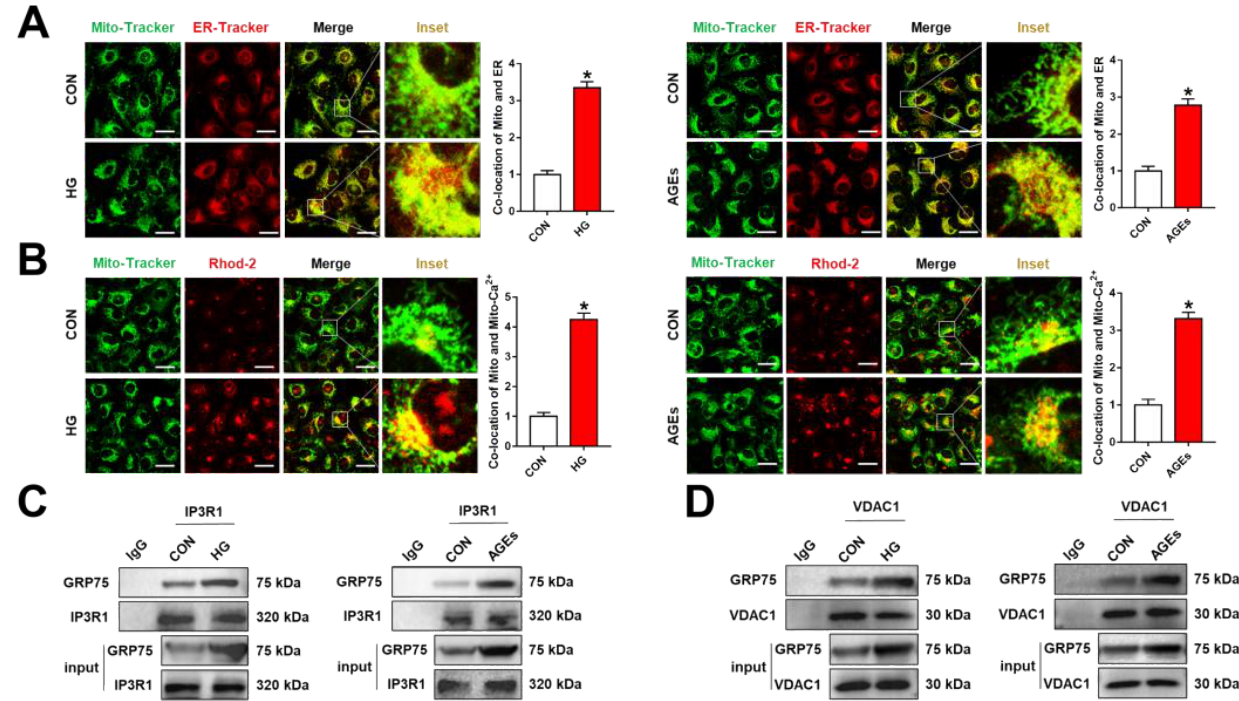
Figure 1. ER – mitochondrial coupling via the IP3R1 – GRP75 – VDAC1 axis in HG or AGE-induced RMECs. RMECs were treated with HG (33 mM) or AGEs (200 µ g/mL) for 48 h. ( A , B ) Mito-Tracker Green (200 nM, 30 min), ER-Tracker Red (1 µ M, 30 min), and Rhod-2 AM (2 µ M, 30 min) were used as mitochondrial, ER, and mitochondrial Ca 2+ markers, respectively. Co-localization of mitochon- drial and ER, mitochondrial, and mitochondrial Ca 2+ was inspected through confocal microscopy.